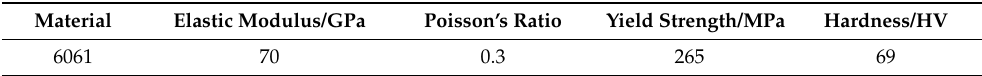
Table 1. Mechanical properties of 6061 aluminum